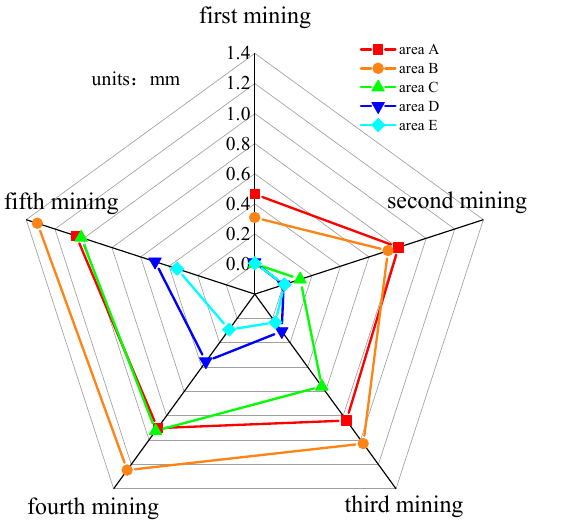
Figure 13. Radar map of average sediment volume change in different regions of the surface.